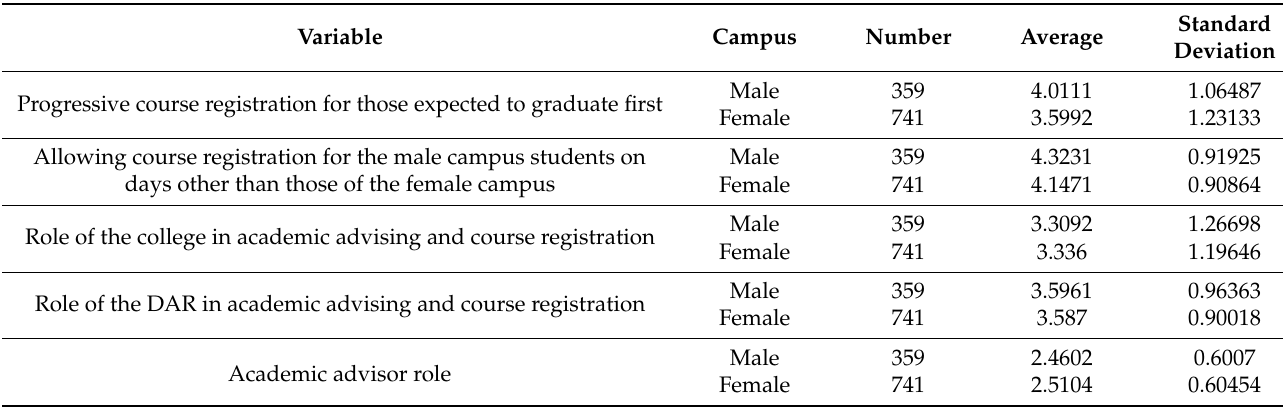
Table 16. Descriptive statistics of study variables by campus.